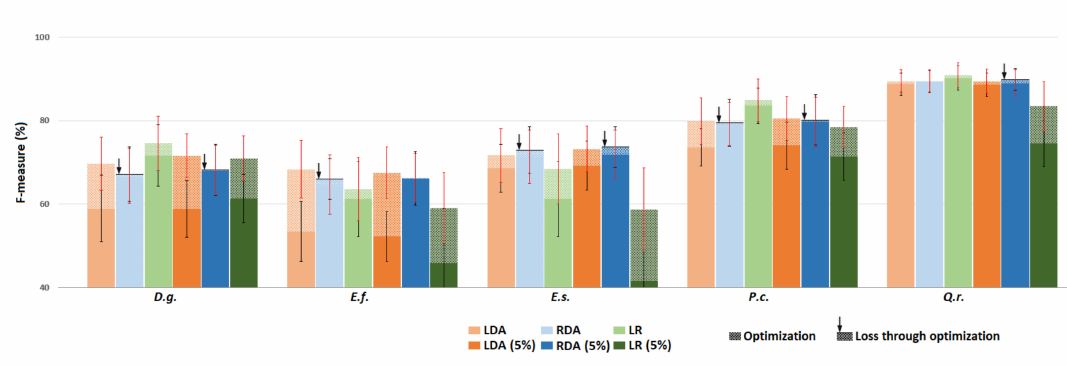
Figure A1. Comparison of classification methods with and without bias. F-measure and its standard deviation are given at object level. Only 30 crowns from the focus class and 100,000 pixels from the non-focus class were used to train the model. Bias consisted in adding 5% of the pixels of the focal species into the non-focal class. Optimization step is represented in the same paler colour. An arrow indicates when optimization decreased performance.